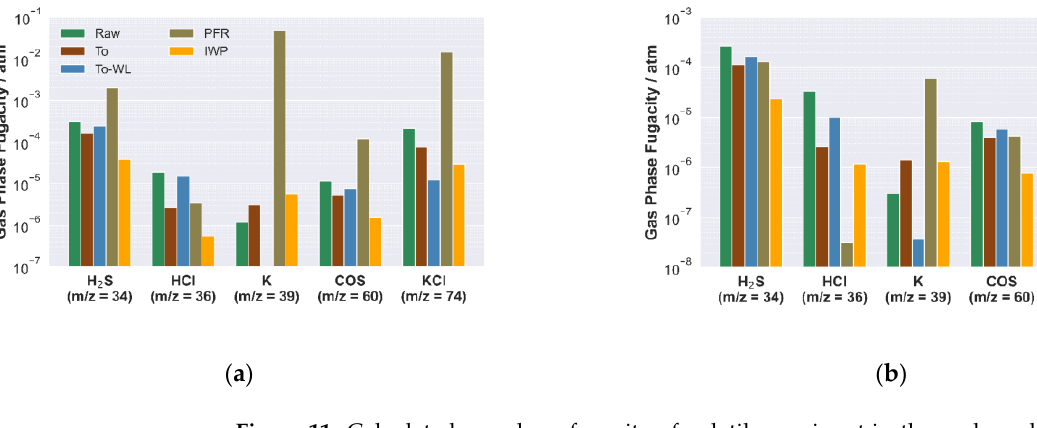
Figure 11. Calculated gas phase fugacity of volatile species at isothermal conditions (950 °C) for pyrolysis-like conditions with no steam/oxygen added ( a ) and gasification-like conditions with steam/oxygen added ( b ).